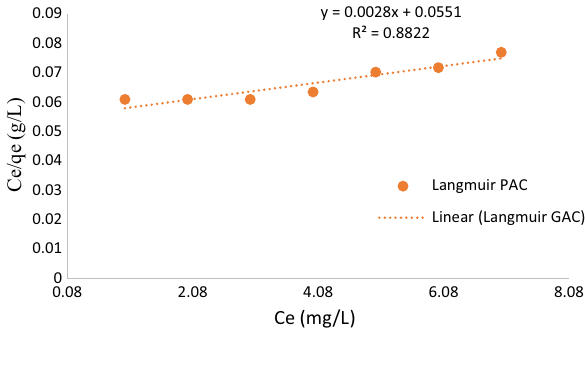
Fig. 10 Plot of C e /q e versus C e for Langmuir isotherm for PAC